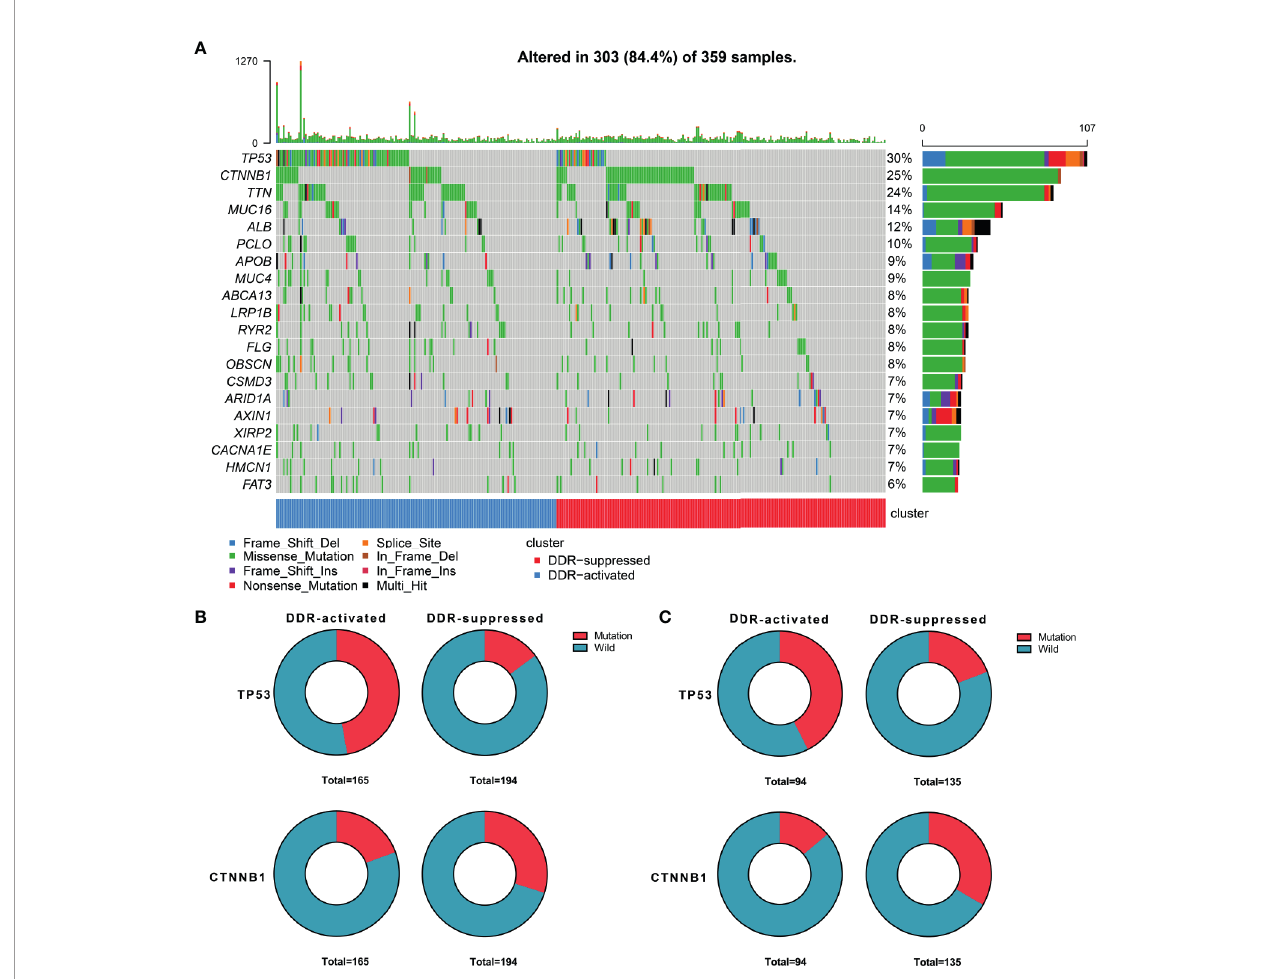
FIGURE 2 | Genomic alterations between DDR-activated and DDR-suppressed subgroups. (A) Landscape of mutation pro fi les in HCC samples. Mutation information of each gene in each sample is shown in the waterfall plot. Top panel shows individual tumor mutation burden. The data shown were analyzed based on the TCGA data portal. (B) The mutation rate of TP53 was higher in the DDR-activated subgroup, while CTNNB1 was higher in the DDR-suppressed subgroup in the TCGA dataset. (C) The mutation rate of TP53 was higher in the DDR-activated subgroup, while CTNNB1 was higher in the DDR-suppressed subgroup in the ICGC